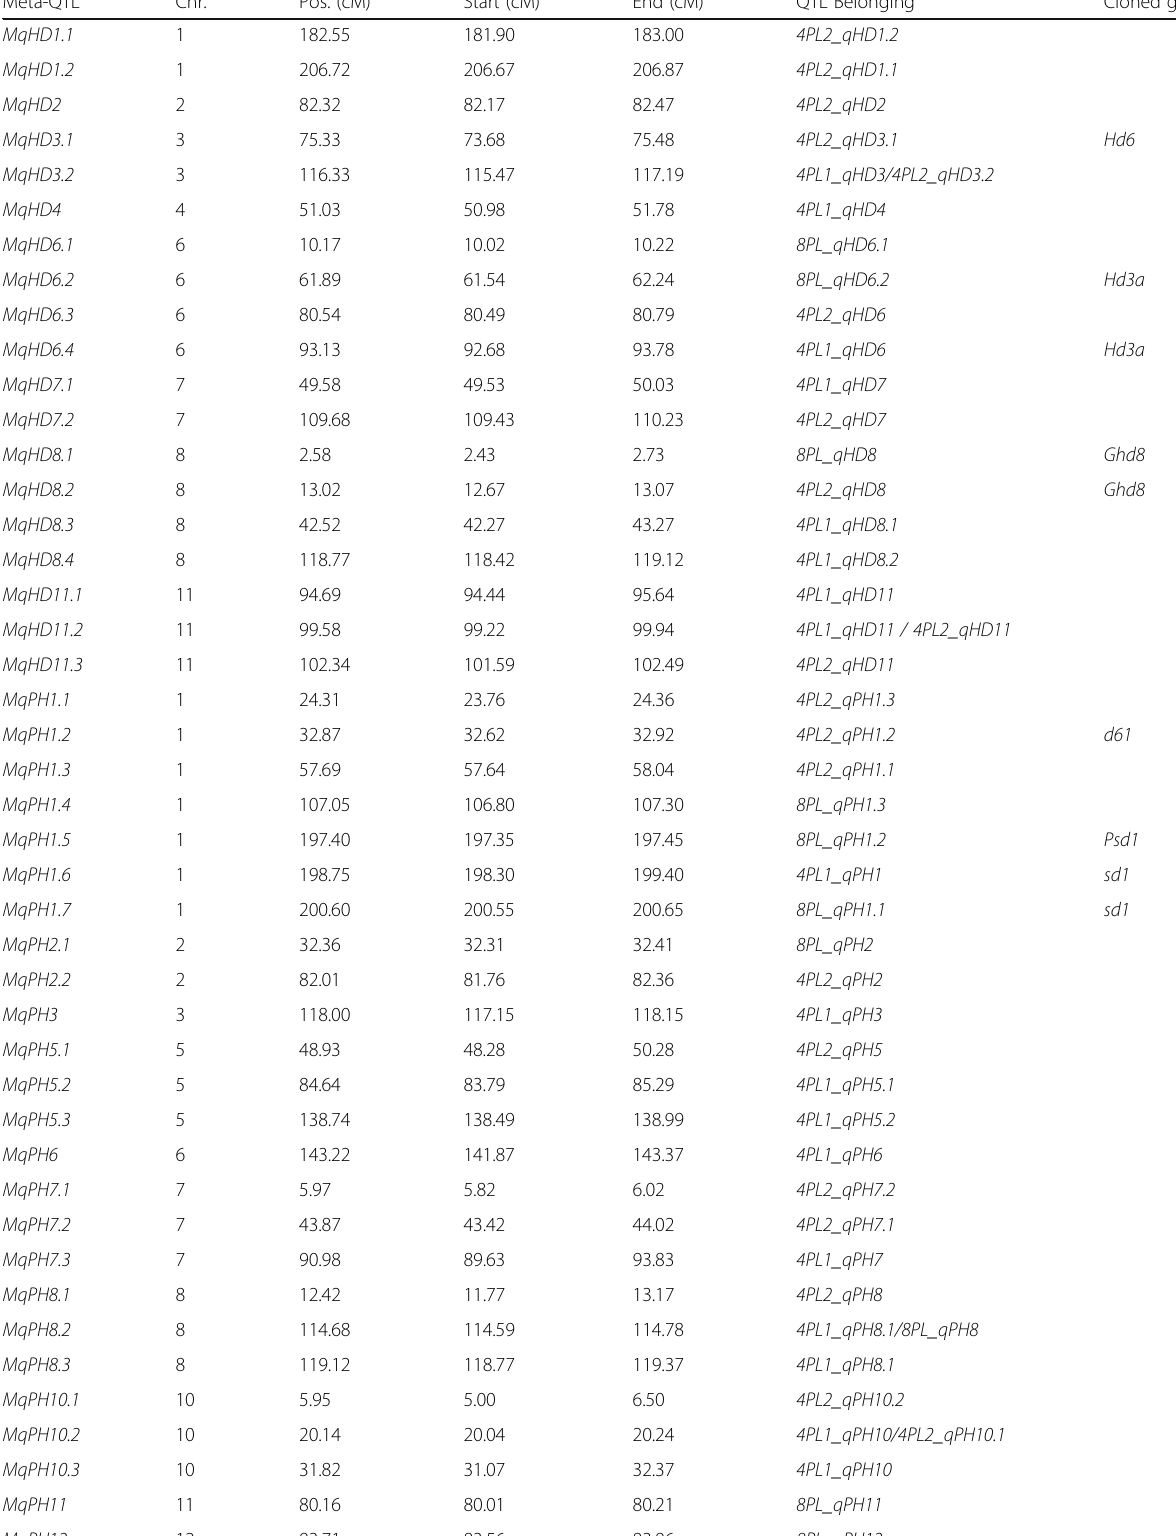
Table 4 QTLs for heading date and plant height detected by meta-analysis Meta-QTL